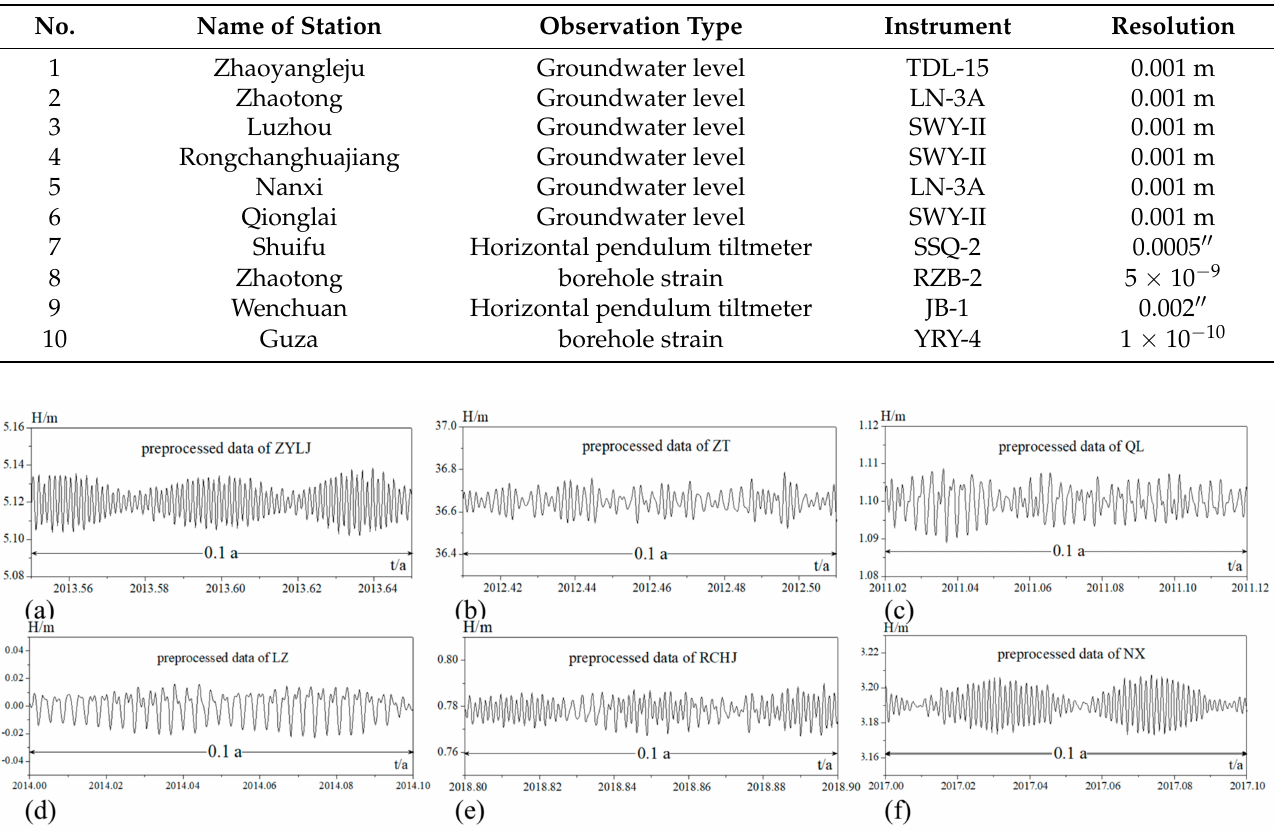
Figure 6. Examples of the filtered water level data. The curve in ( a ) is from the ZYLJ well, ( b ) from the ZT, ( c ) QL, ( d ) LZ, ( e ) RCHJ, ( f )